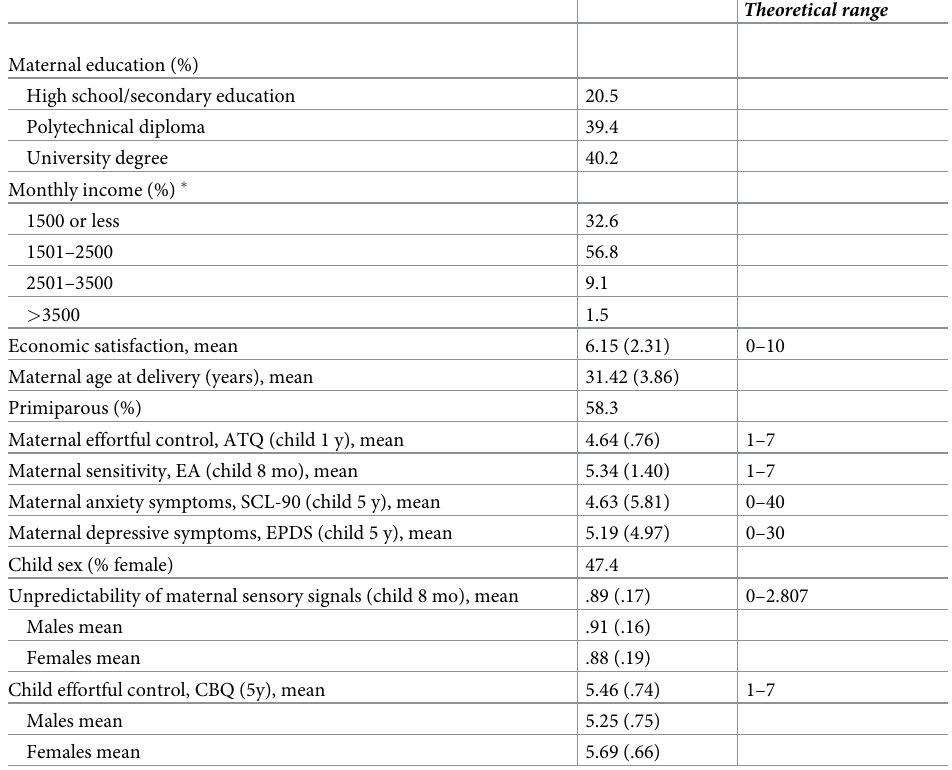
Table 2. Demographic characteristics of the sample (n =